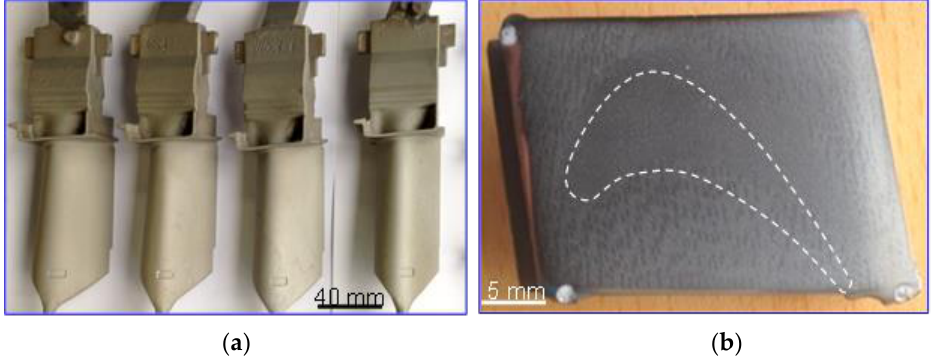
Figure 7. Casting results of the PWA1483 alloy. ( a ) Etched blade castings; ( b ) the corresponding platform, revealing SG-free structure.